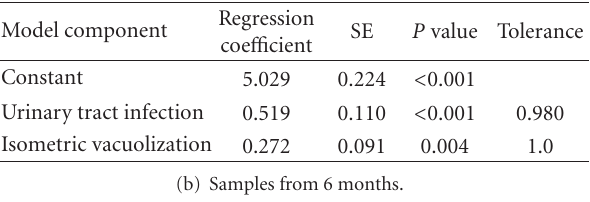
(b) Samples from 6 months.